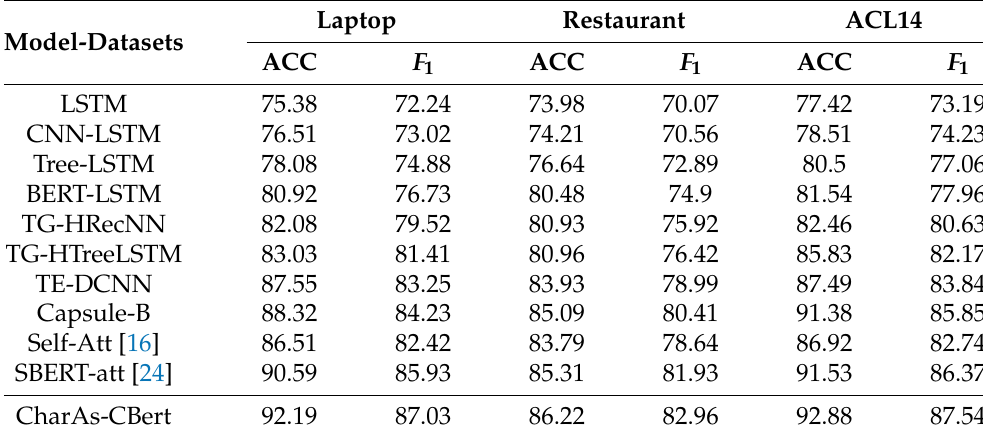
Table 2. Experimental results of different sentence representation methods. SemEval2014 including Laptop and